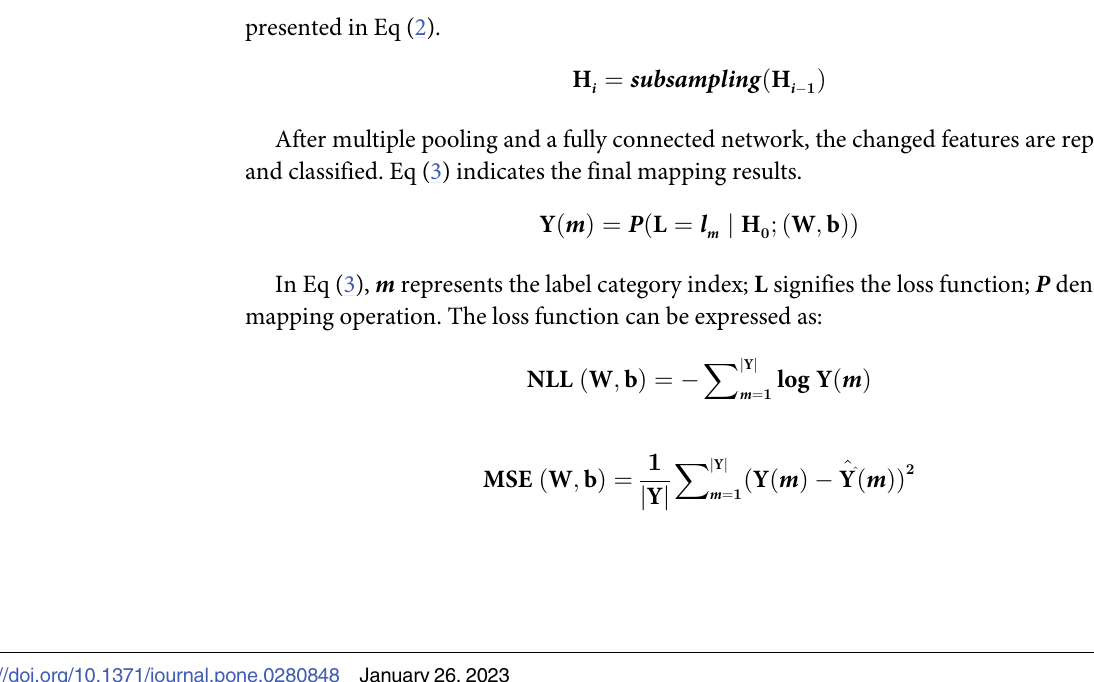
Fig 3. Movie poster analysis model (a: Poster analysis process; b: Poster analysis principle).